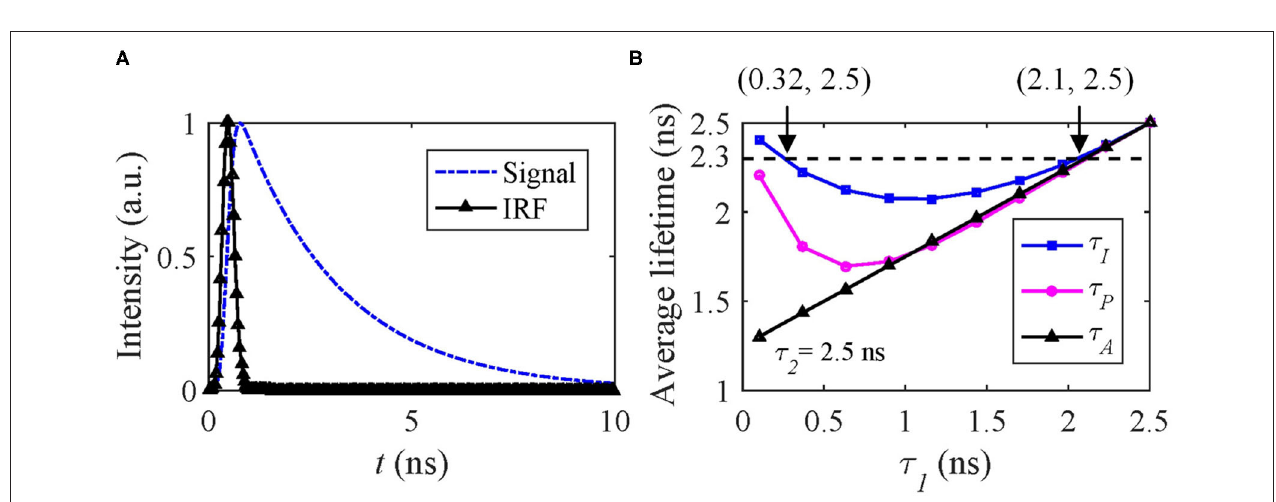
FIGURE 5 | (A) Simulated signal (blue) and IRF (black), (B) theoretical τ I (blue), τ A (black), and τ P (magenta) average lifetimes with q 1